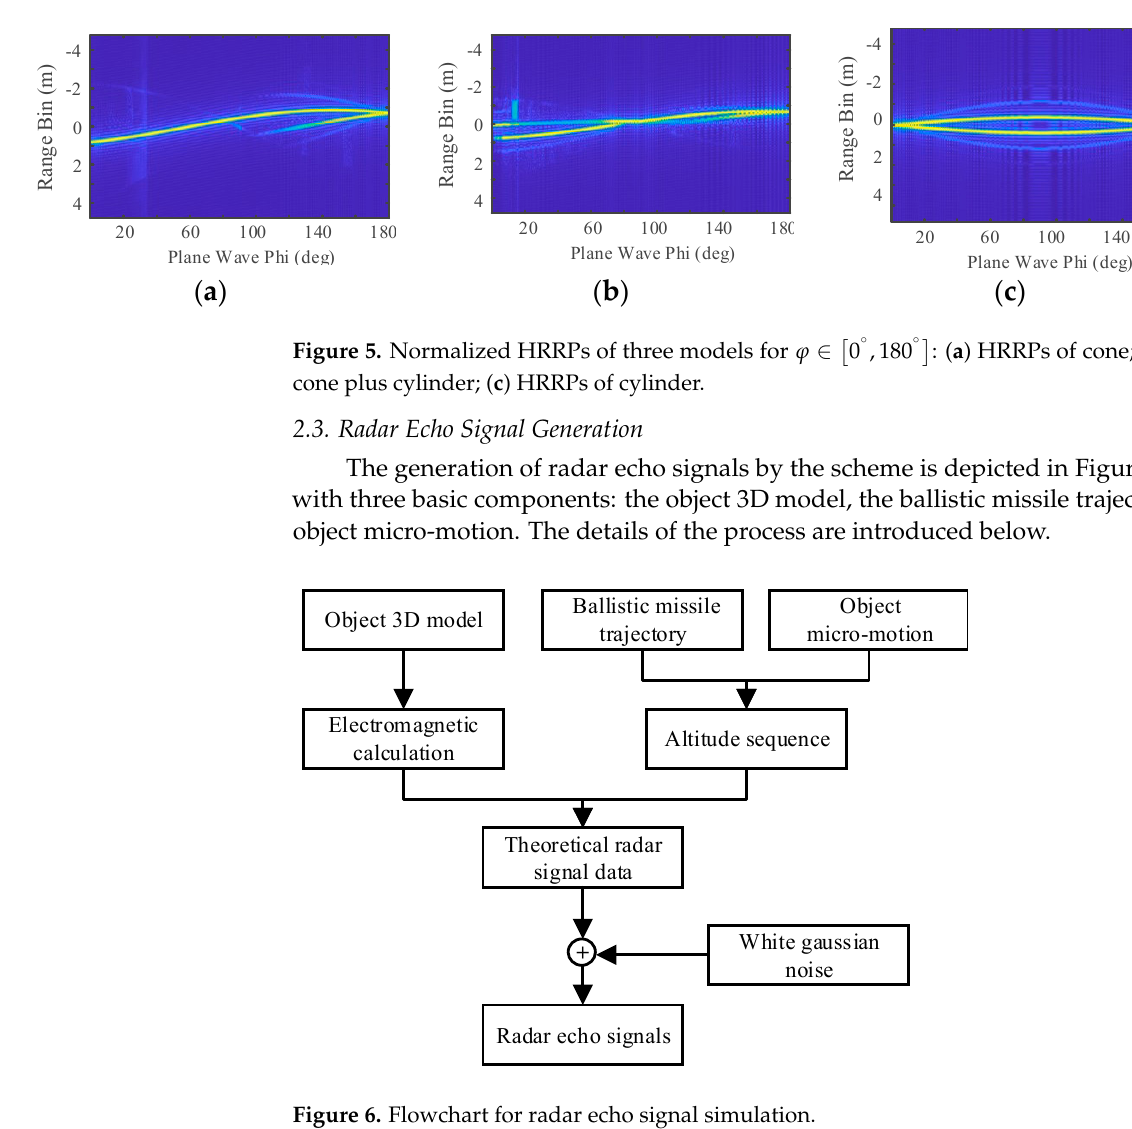
Figure 6. Flowchart for radar echo signal simulation. Table 1. Ground-based radar net parameters .